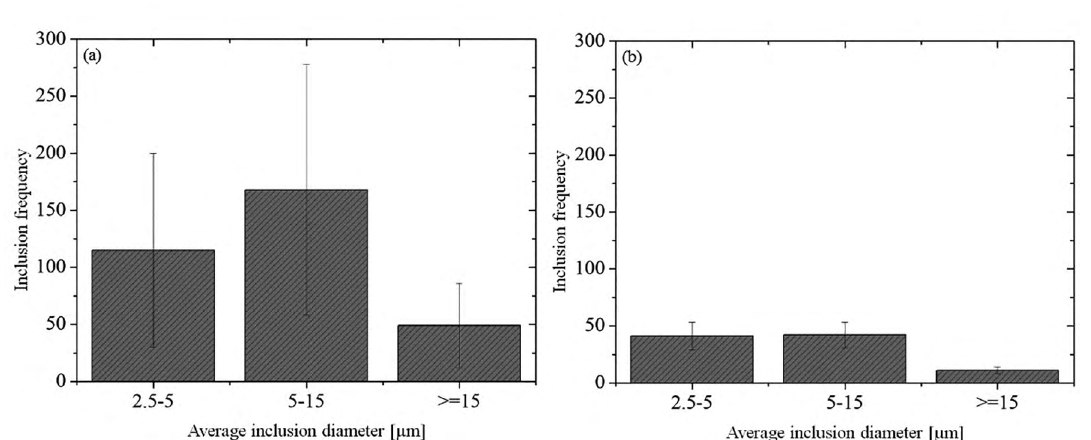
Figure 2. Inclusion frequency for each average inclusion diameter range (a) before and (b) after vacuum degassing.